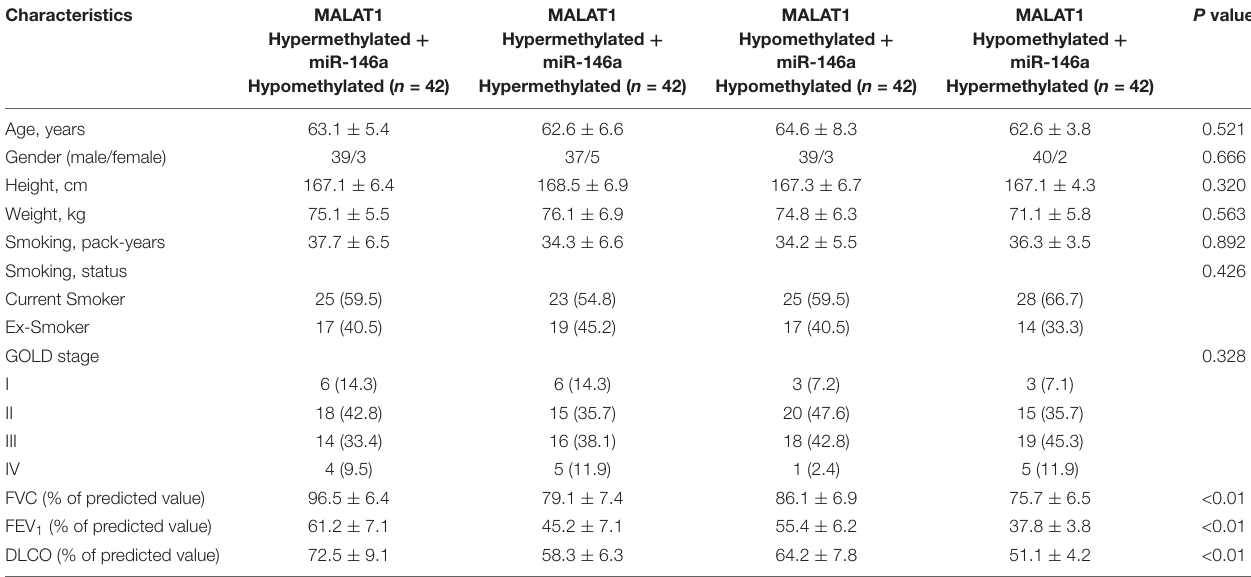
TABLE 1 | Demographic and clinicopathological characteristics of the participants in this study.